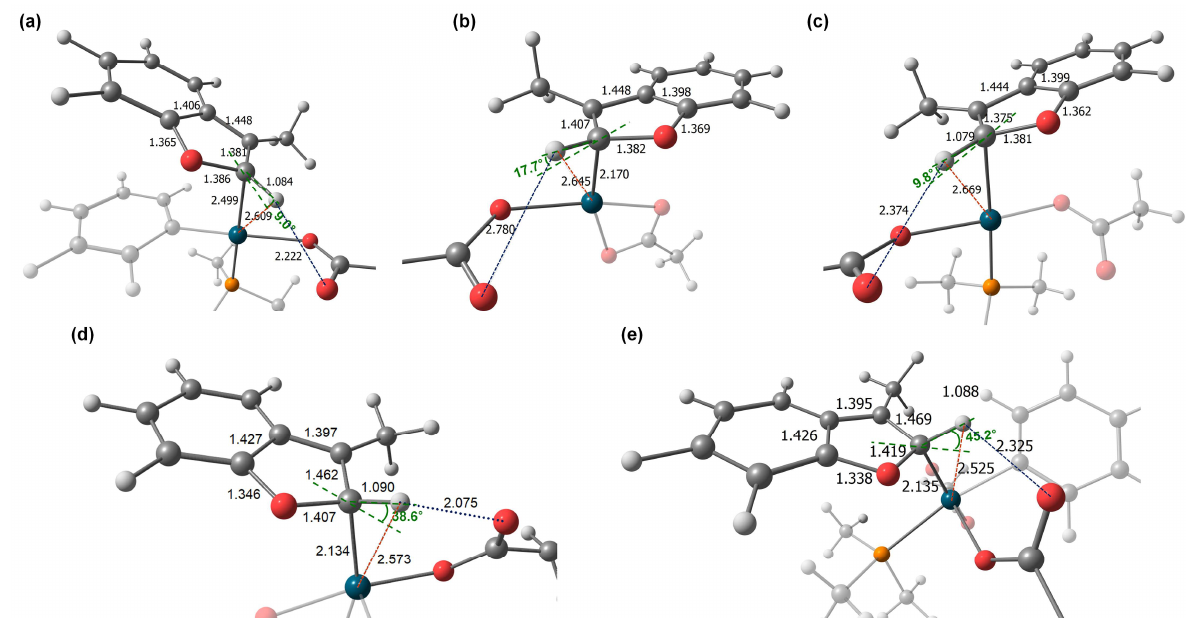
Figure 2. Optimized geometries of intermediate states prior to the C−H bond cleavage: ( a ) I_1 (Figure 1), ( b ) II_1 (Figure 3), ( c ) III_1 (Figure 4), ( d ) IV_1 (Figure 5), and ( e ) V_1 (Figure 6). Interactions between acetate oxygen atom and C( sp 2 )−H atoms are shown as blue do(cid:308)ed lines. Pd−H interactions are shown as orange do(cid:308)ed lines. Deviation angles (α) defined in the figure of Table 2 are displayed in green. Note that ( a – c ) are neutral and ( d – e ) are +1 cationic.